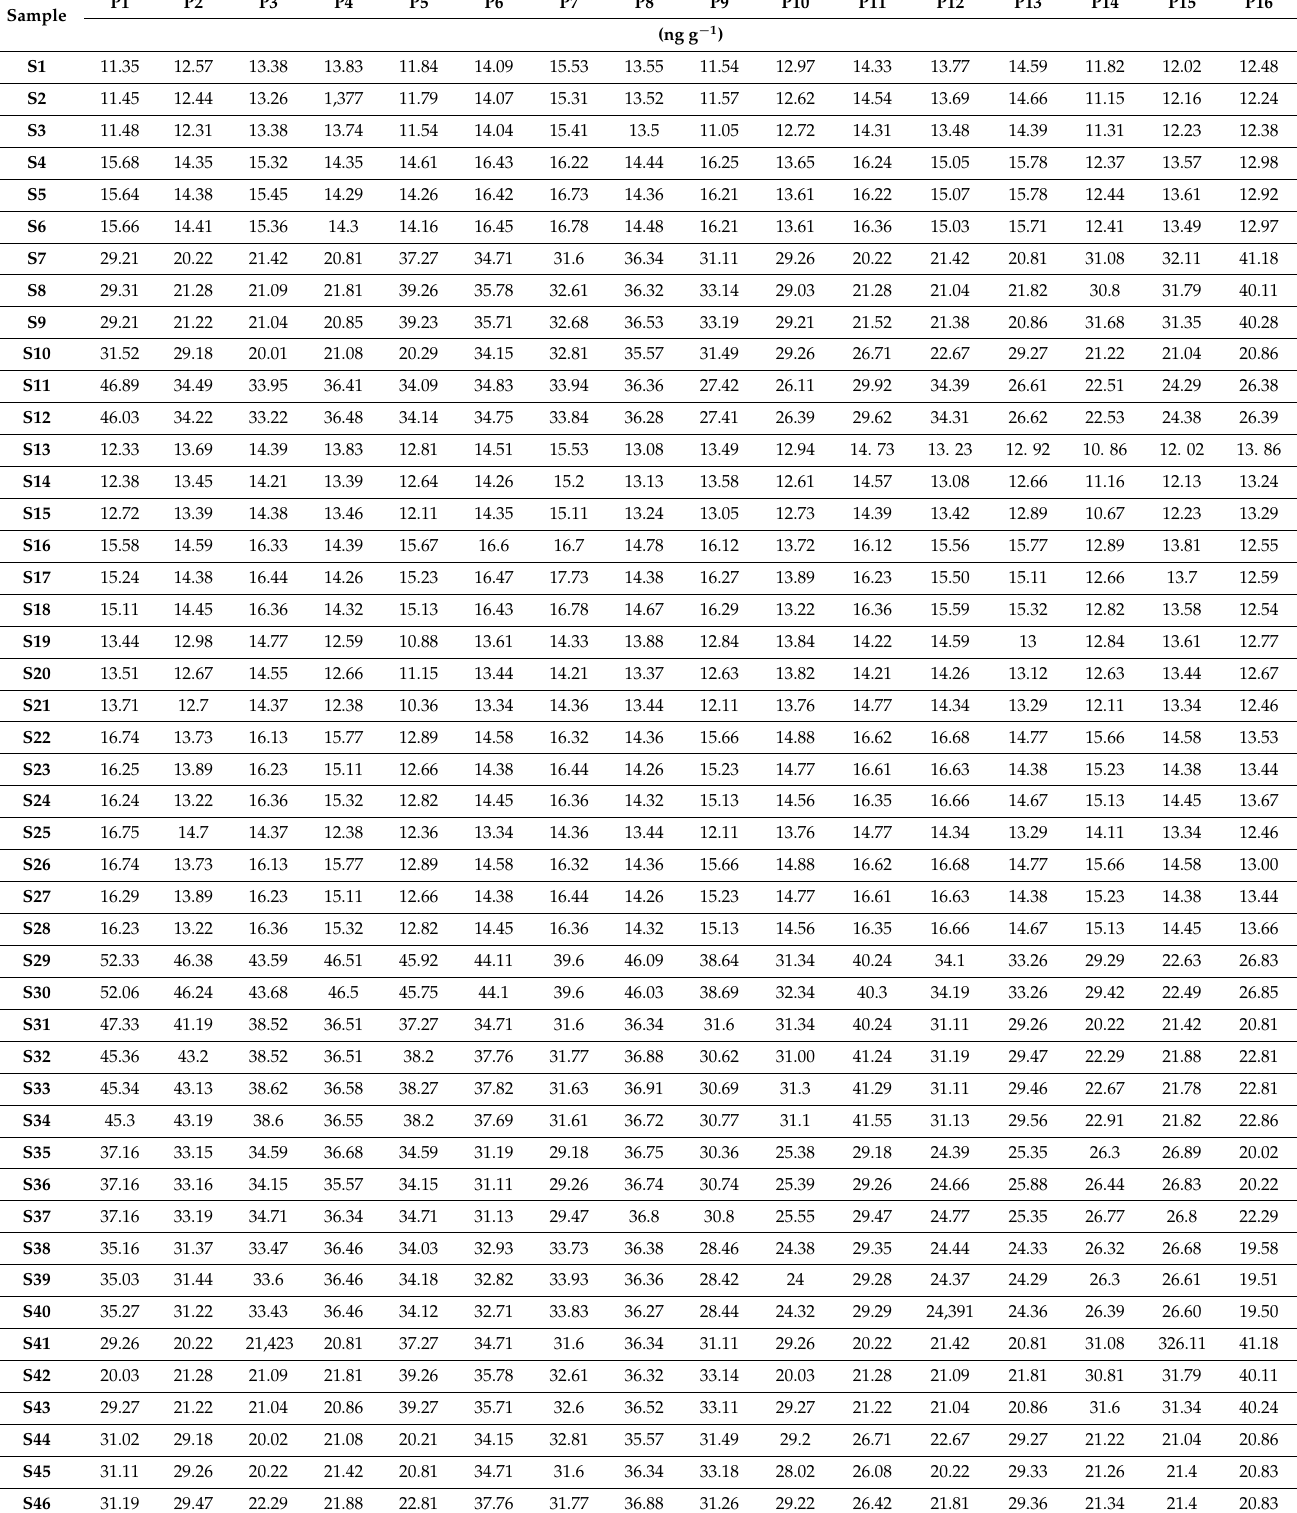
Table 2. Concentration of PAHs in road dust samples of Riyadh